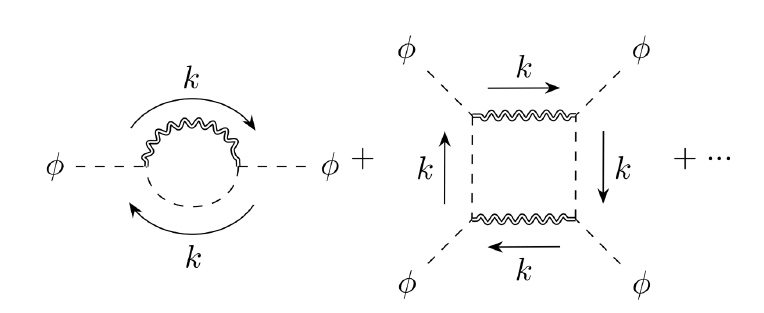
Figure 1 . 1PI diagrams of the φ 2 h interaction contributing to the potential at the one-loop approximation.